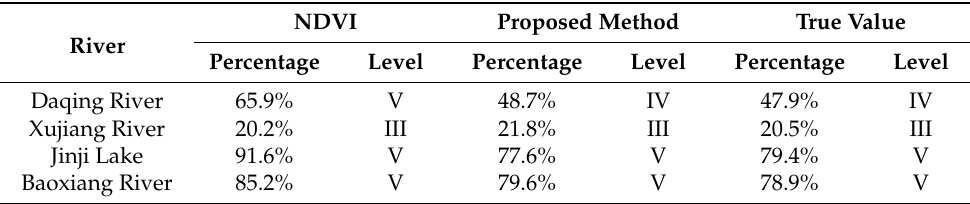
Table 6. Estimated area of cyanobacterial-bloom contamination and determination of pollution level in typical rivers.